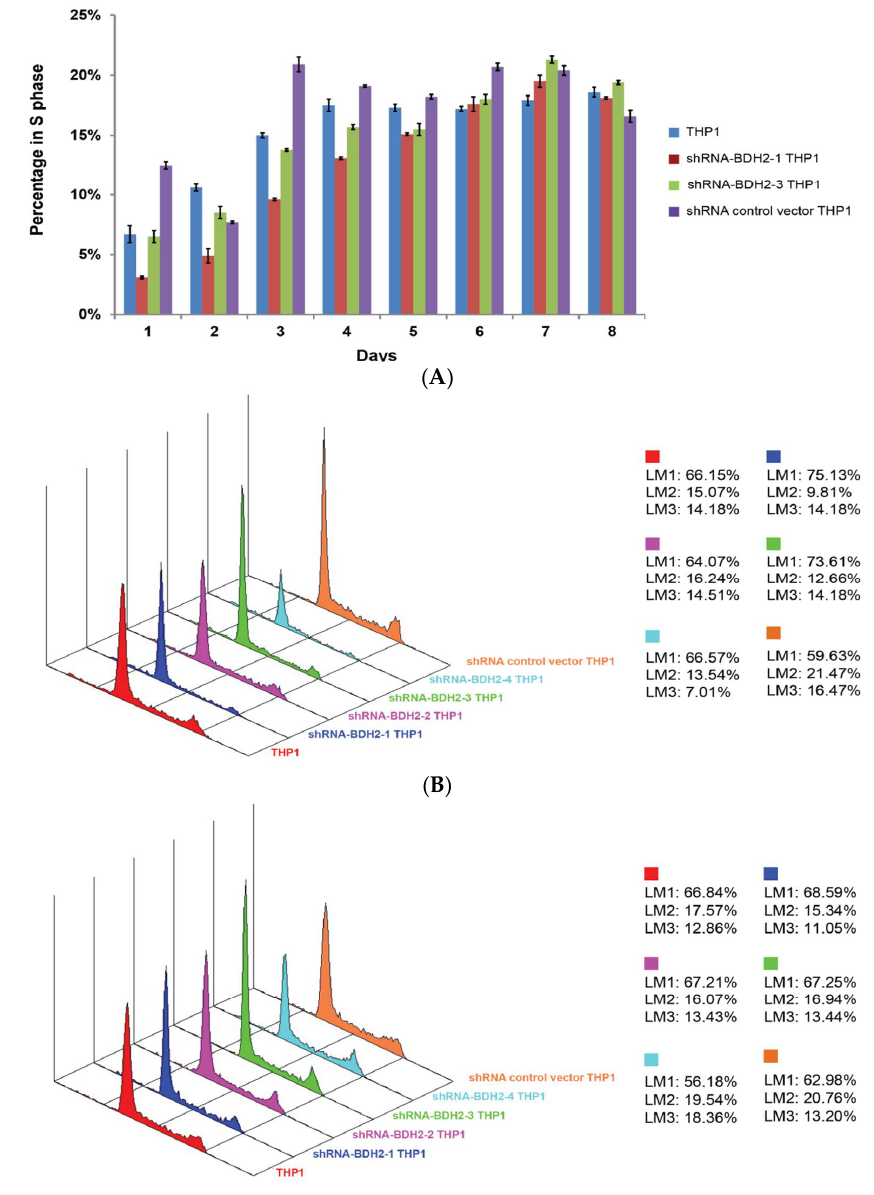
Figure 4. Cell cycle profile of native THP1 and shRNA control vector transfected THP1 cells from starving condition. ( A ) Cell cycle profile at the synthesis phase. ( B ) Analysis graphs on the third and ( C ) fourth days after re-culture with FBS. Native THP1 and shRNA control vector transfected THP1 cells entered S phase on day 3, while BDH2-KD THP1 cells started S phase on day 4. BDH2, hydroxybutyrate dehydrogenase type 2; FBS, fetal bovine serum. LM1: G0/G1; LM2: S; LM3: G2/M.